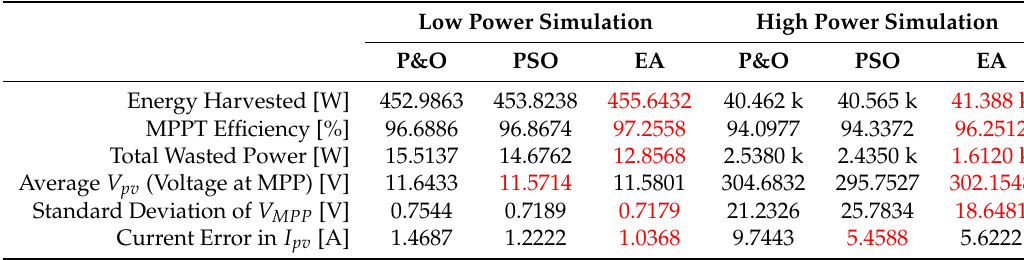
Table 6. Summary of the quantified